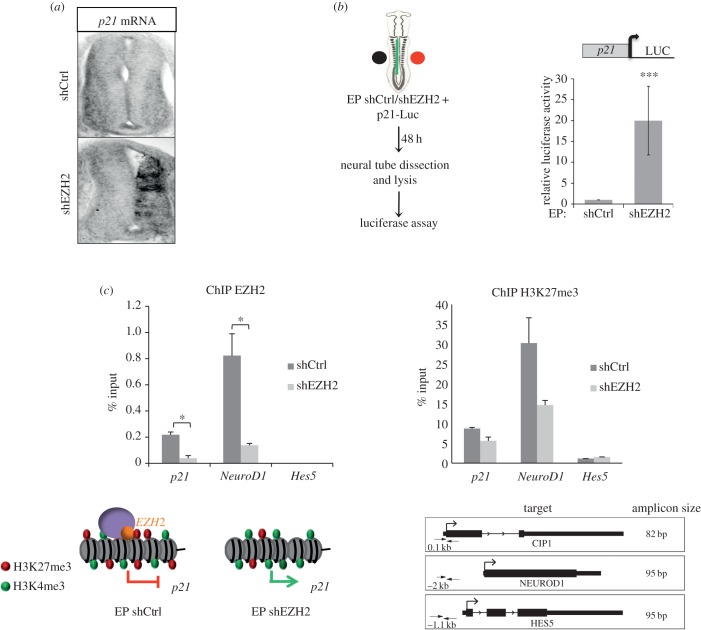
EZH2 targets p21WAF1/CIP1 promoter. (a) p21WAF1/CIP1 ISH 48 h after in ovo electroporation of shCtrl or shEZH2 in HH11–12 embryo neural tubes. (b) HH11–12 embryos were electroporated in ovo with shCtrl or shEZH2 together with p21WAF1/CIP1 promoter fused to the luciferase and pCMV-β-gal reporter used as internal control; 48 h PE the neural tubes were dissected, the tissue was disaggregated and the luciferase activity measured using the Life Technologies dual kit. Data represent mean of three experiments from four to six embryos. Error bars indicate s.d. ***p < 0.001. (c) ChIPs analysed by qPCR from HH11–12 electroporated neural tube cells with shCtrl or shEZH2 (48 h PE) using EZH2 or H3K27me3 antibodies at the p21WAF1/CIP1, NeuroD1 and Hes5 promoters. Results are represented as percentage of input. Map of the genes and the position and length of the amplicons are shown in the bottom part of the figure. Three biological replicates, with ten HH12 embryo neural tubes each, were used in each experiment. Error bars indicate s.d. *p < 0.05.